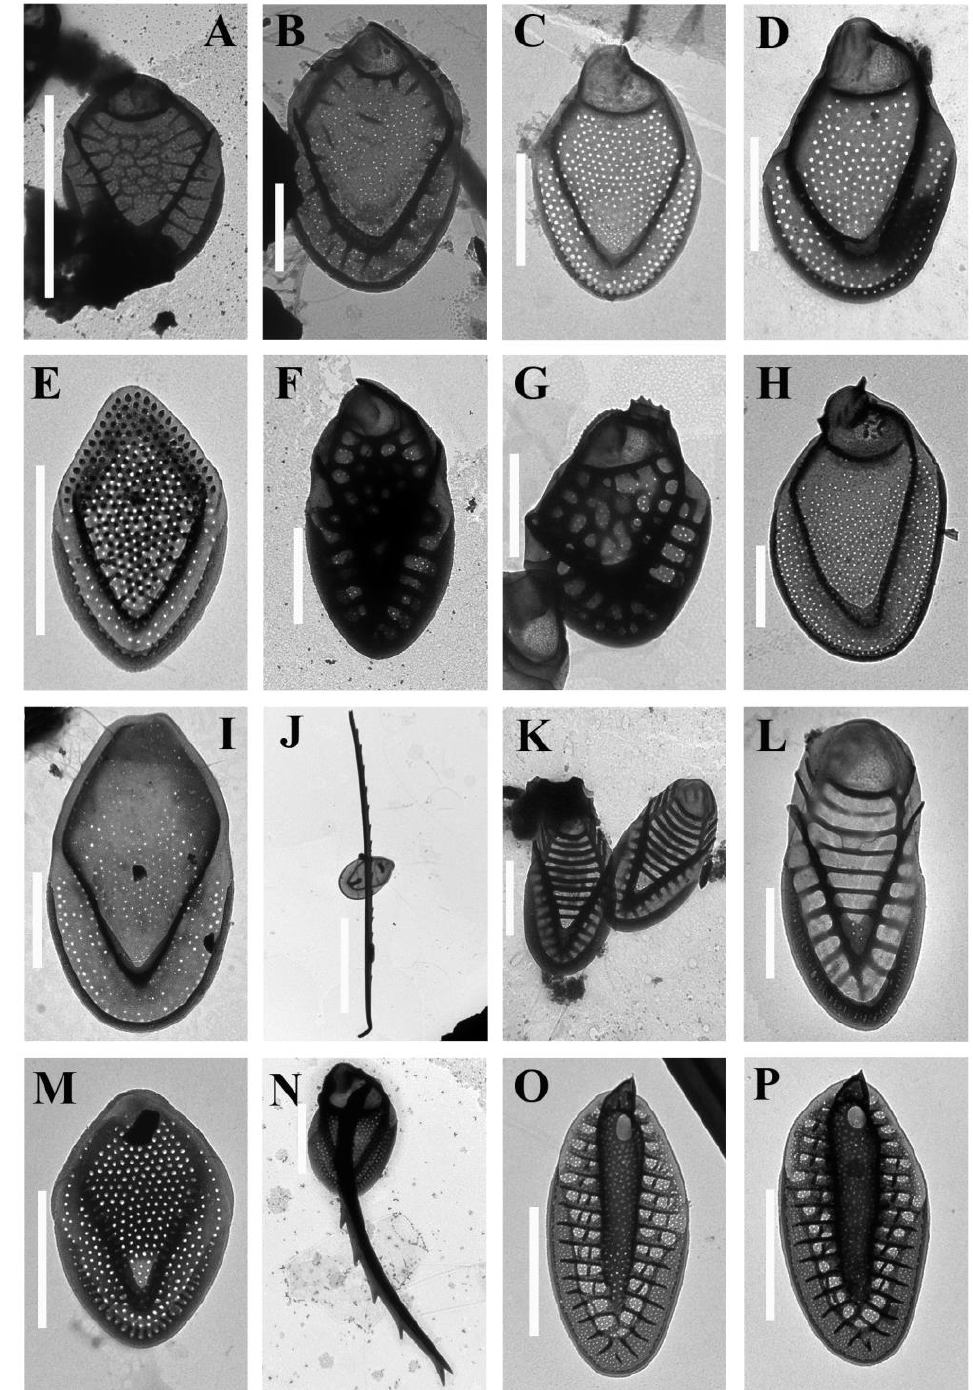
Figure 3. Mallomonas and Synura taxa from Teletskoye Lake and adjacent area , TEM. ( A , B ) Mallomonas acaroides , body scales ; ( C , D ) Mallomonas alpina , body scale ( C ) and apical scale ( D ) ; ( E ) Mallomonas annulata body scale; ( F , G ) Mallomonas crassisquama , body scale ( F ) and apical scale ( G ); ( H – J ) Mallomonas elongata , domed body scale; ( H ), domeless body scale ( I ) and bristle ( J ); ( K , L ) Mallomonas pechlaneri , body scales; ( M , N ) Mallomonas tonsurata , domeless body scale ( M ) and domed scale with bristle ( N ); and ( O , P ) Synura petersenii, body scales . Scale bars: ( J ) : 10 μm; ( A ) : 5 μm; ( B – I , K , M – P ) : 2 μm; and ( L ) : 1 μm.